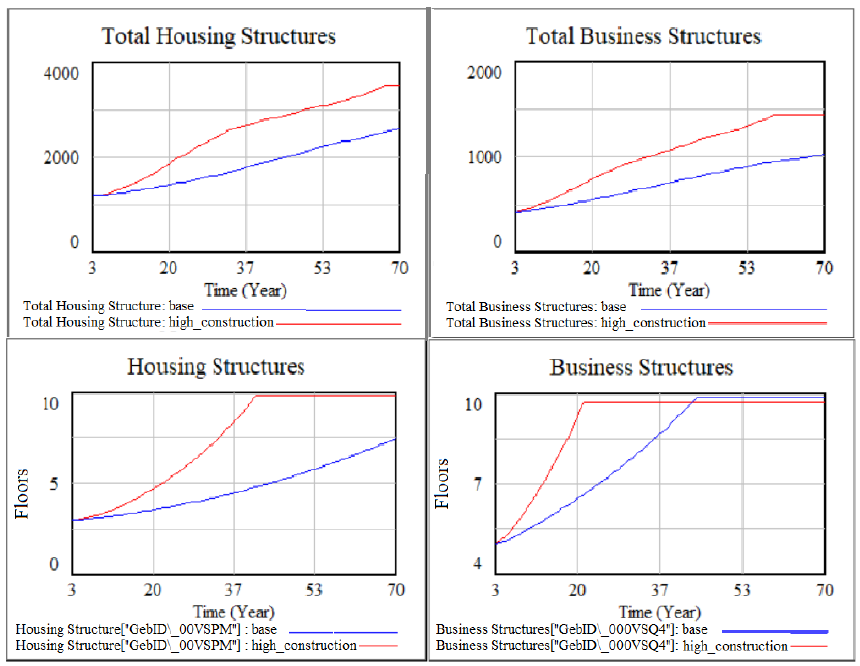
Figure 6: Simulation results for two scenarios with respect to building